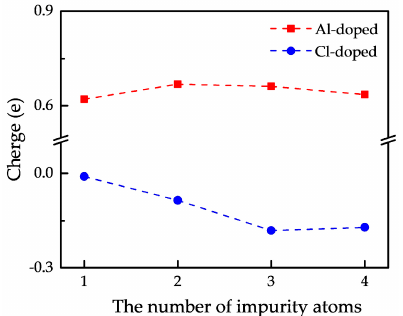
Figure 10. The curves about average charge on impurity atoms in doped phosphorene versus the number of impurity atoms.